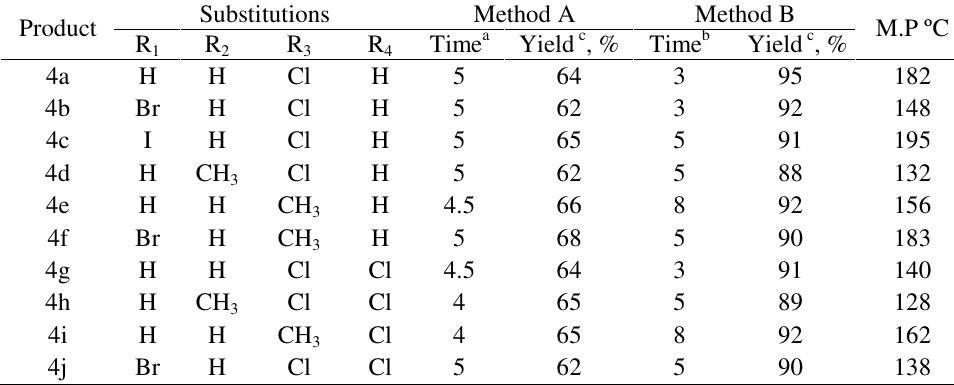
Table 1. Synthesis of Hantzsch thiazole derivatives under solvent free